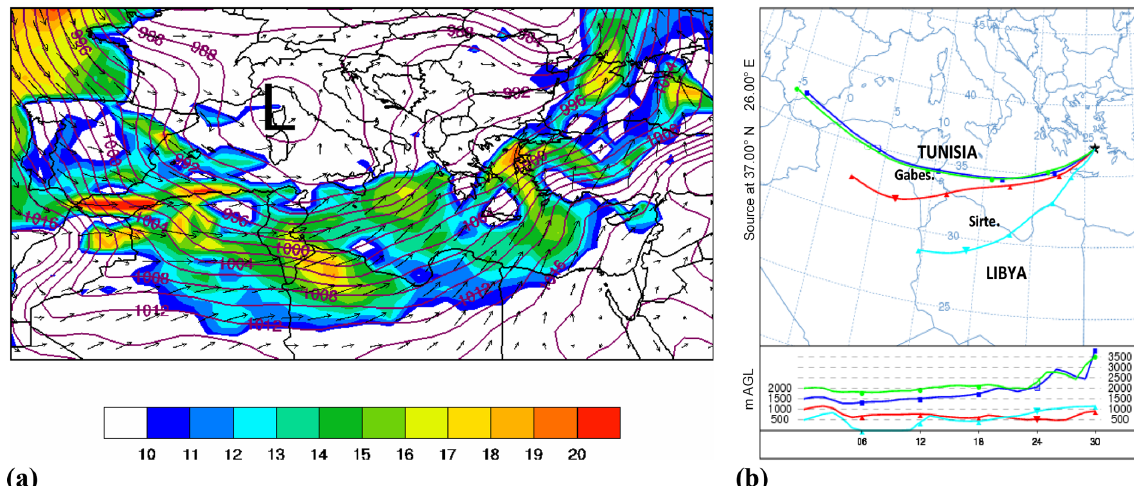
Figure 1. NCEP final analysis data (FNL) at 12:00UTC, 31 Januray 2015 (a) . The wind speed > 10ms − 1 at 1000hPa is shown (colour scale and vectors) overlaid with mean sea level pressure (contour lines). The low-pressure centre is denoted with L. The HYSPLIT back-trajectories arrive over the Aegean Sea at 12:00UTC, 1 February 2015 (b)